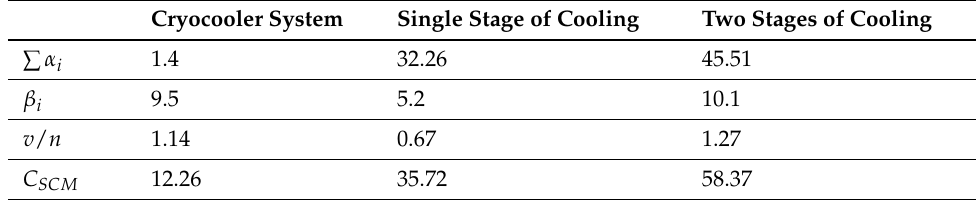
Table 7. Complexity assessment results for a thermal management